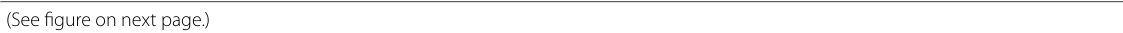
(See figure on next Fig. 3 Hierarchical clustering analysis (HCA) and heat map analysis on relative abundances of ruminal fungi content from three treatments: CON, control diet; HC, high-concentrate diet; HCT, high-concentrate diet supplemented with 180 mg thiamine/kg DMI. a HCA and heat map analysis on relative abundances of fungi class in rumen fluid; b HCA and heat map analysis on top 30 relative abundances of fungi species in rumen fluid. Rows represent fungi and columns represent samples. Cells were colored based on the relative abundance of fungi measured in rumen, red represents high rumen levels while green represents low signal intensity and black cells showing the intermediate level